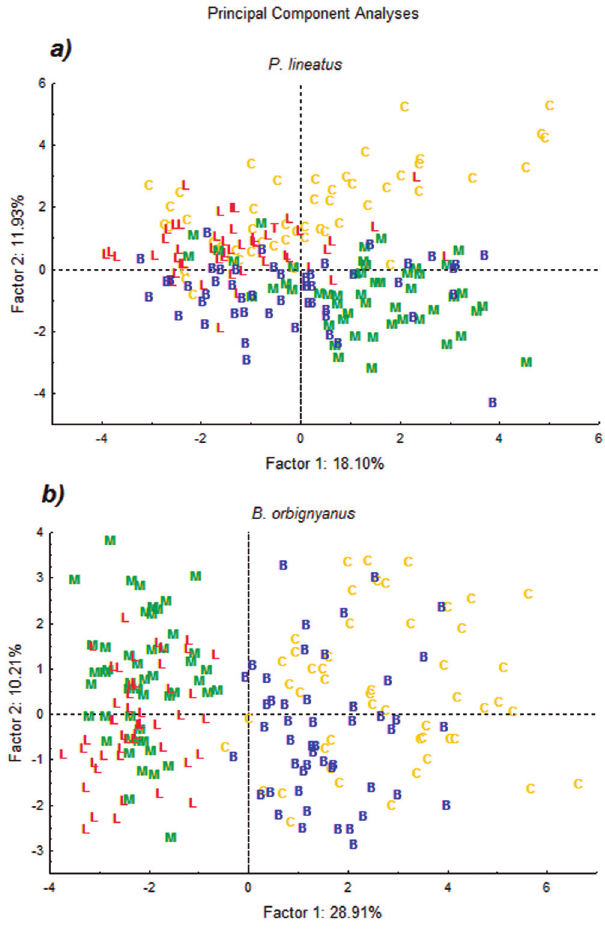
Fig. 4. Projection of the four treatments [C = control; L = logs; M = macrophytes; and B = both (logs+macrophytes)] in the first two axes of the Principal Component Analysis for Prochilodus lineatus and for Brycon orbignyanus